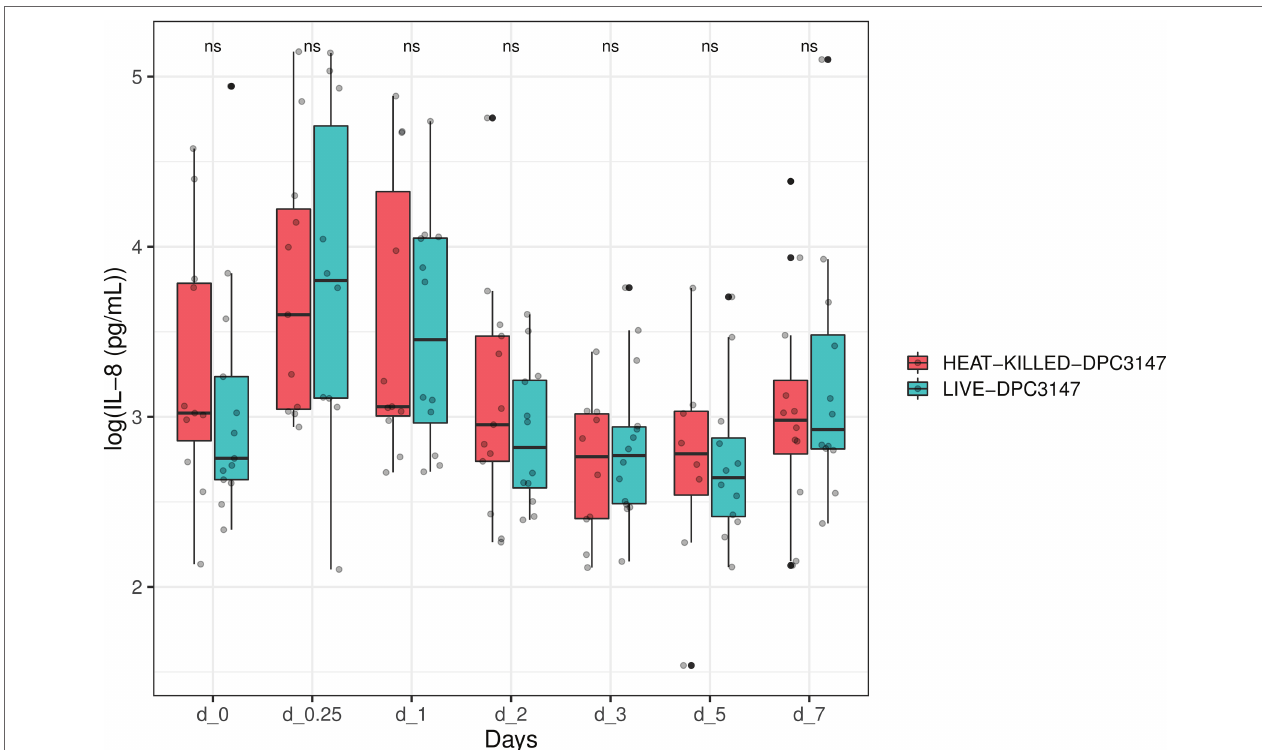
FIGURE 1 | A non-parametric Wilcoxon test was used to compare the IL-8 titres elicited by viable Lactococcus lactis DPC3147 cells versus heat-killed DPC3147 cells. The figure shows that there was no significant difference in IL-8 responses in cows treated with either viable DPC3147 cells or heat-killed DPC3147 cells at any of the time points ( p > 0.05). This indicates that heat-killed cells can elicit an equally potent IL-8 response as viable DPC3147